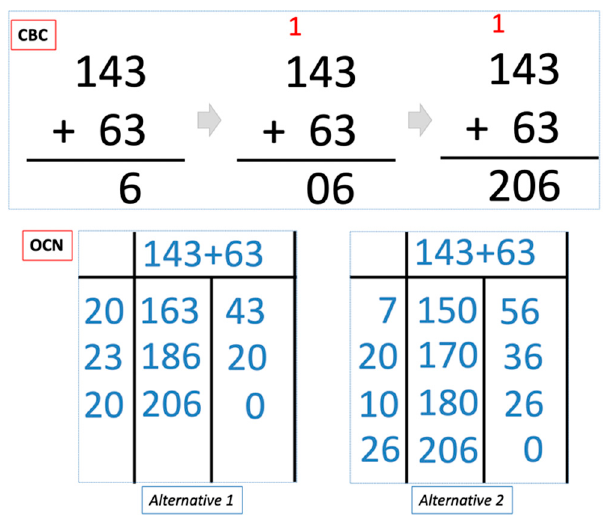
Figure 2. An example of the closed algorithm based on ciphers (CBC) and open calculation based on numbers (OCN) addition methodology for the class proposed toward mathematics learning in a flipped classroom.